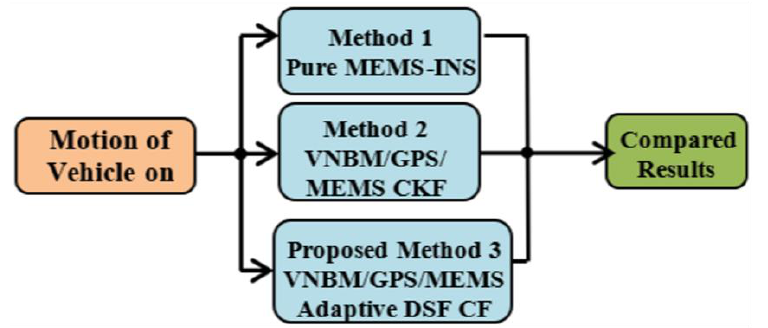
Figure 6. Structure of the three integrated methods.